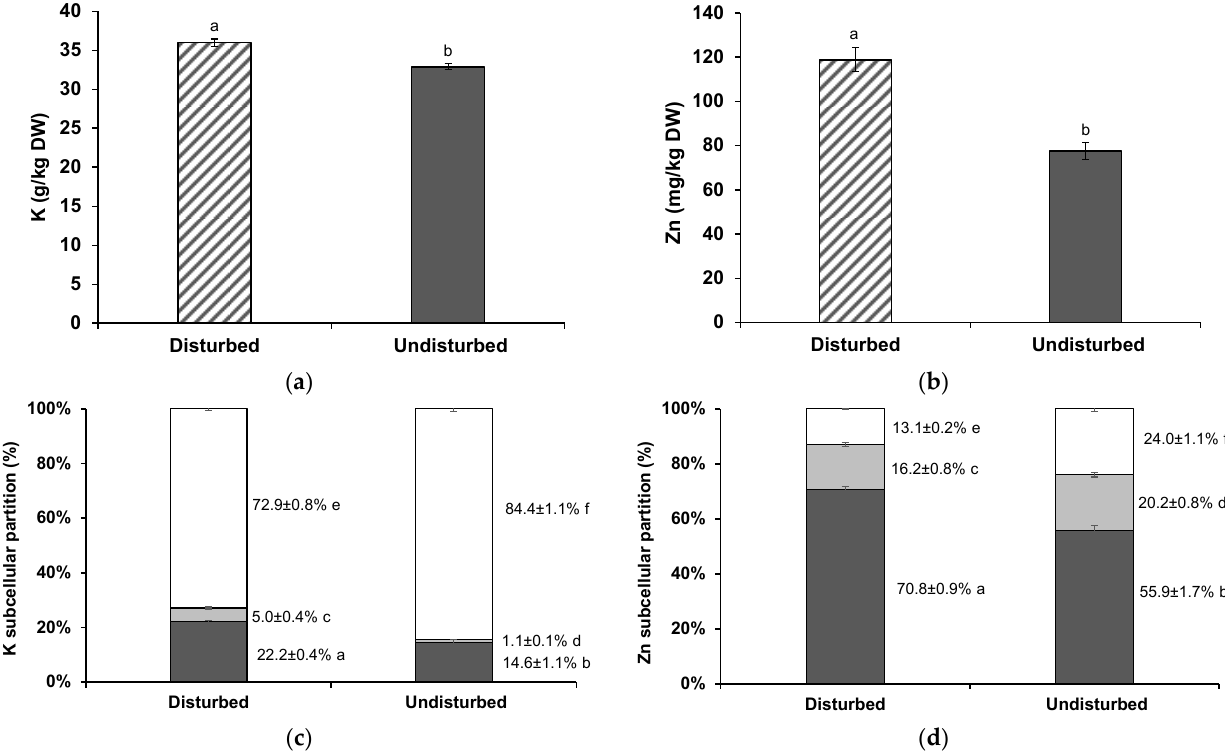
Figure 3. Concentration (average and standard error) of K ( a ) and Zn ( b ) in the shoots of wheat plants grown in disturbed (striped columns) or undisturbed (grey columns) acidic soil, after Ornithopus compressus growth. The proportions (average and standard error) in the cell wall fraction (dark grey columns), organelle fraction (light grey columns), and vacuole contents fraction (white columns) were also determined for K ( c ) and Zn ( d ). Values next to bars are the element percentages for each fraction. Different letters indicate statistically significant differences ( p < 0.05).